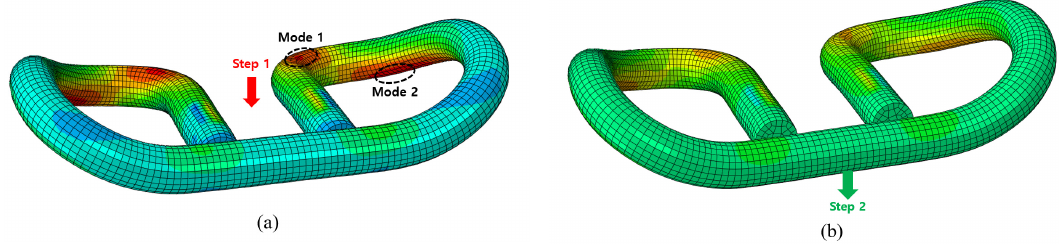
Figure 3. Maximum principal stress contours: ( a ) initial fastening (Step 1); ( b ) vertical displacement (Step 2).